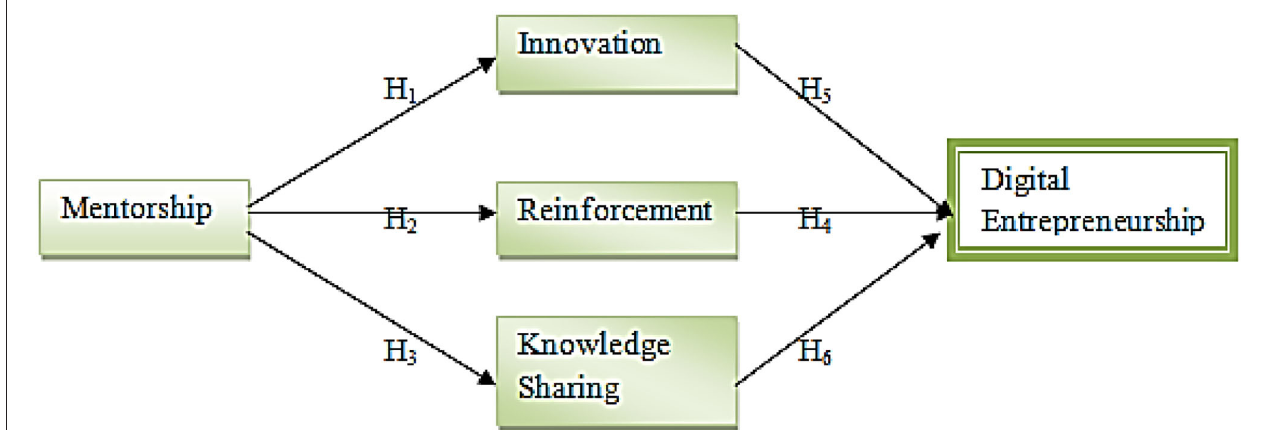
FIGURE 1 | Conceptual